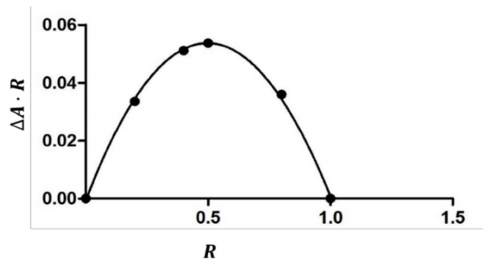
Figure 4. The job plot for the complex HPPA:TRIMEB at λ =324 nm.